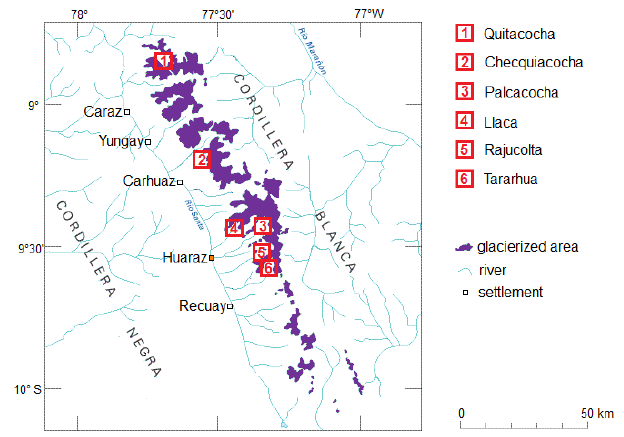
Fig. 1. The location of the selected lakes within the catchment of the Rio Santa in the Cordillera Blanca (base map: